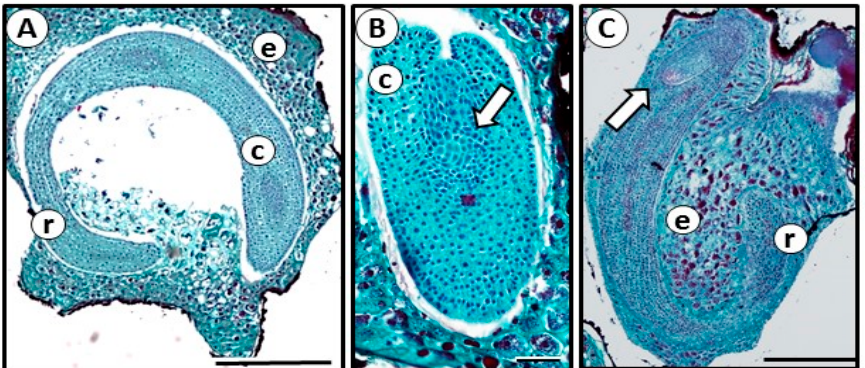
Figure 1. Representative microphotographs of garlic seed structure. Seeds were either imbibed for eight hours ( A , B ) or stratified at 4 °C for eight weeks ( C ). No structural differences were visible. e—endosperm, r—radicle, c—cotyledon. ( A ) Longitudinal section just before sowing. Note dense meristematic area in the upper part of cotyledon. Bar = 0.5 mm. ( B ) Cross-section via upper part of cotyledon. Embryonic SAM (arrow) is visible. Bar = 0.1 mm. ( C ) Longitudinal section of the seed, SAM differentiates the first leaf primordium (arrow). Bar = 0.5 mm.